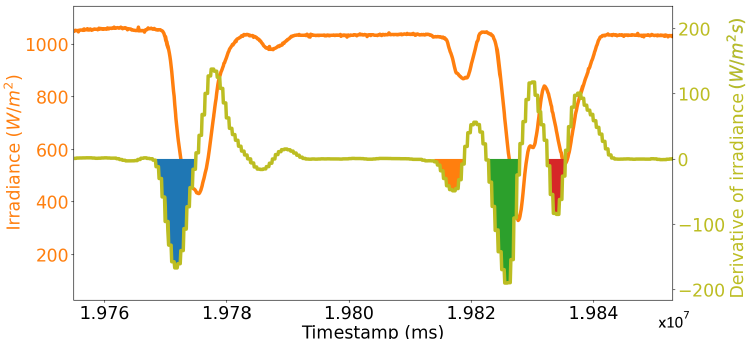
Figure 1. Cloud detection